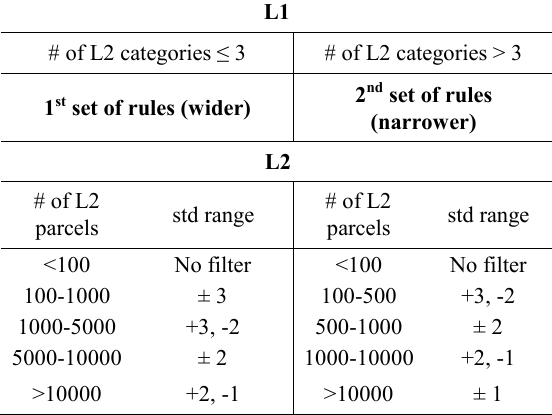
Table 2 . The rule-set of the spectral homogeneity criterion.